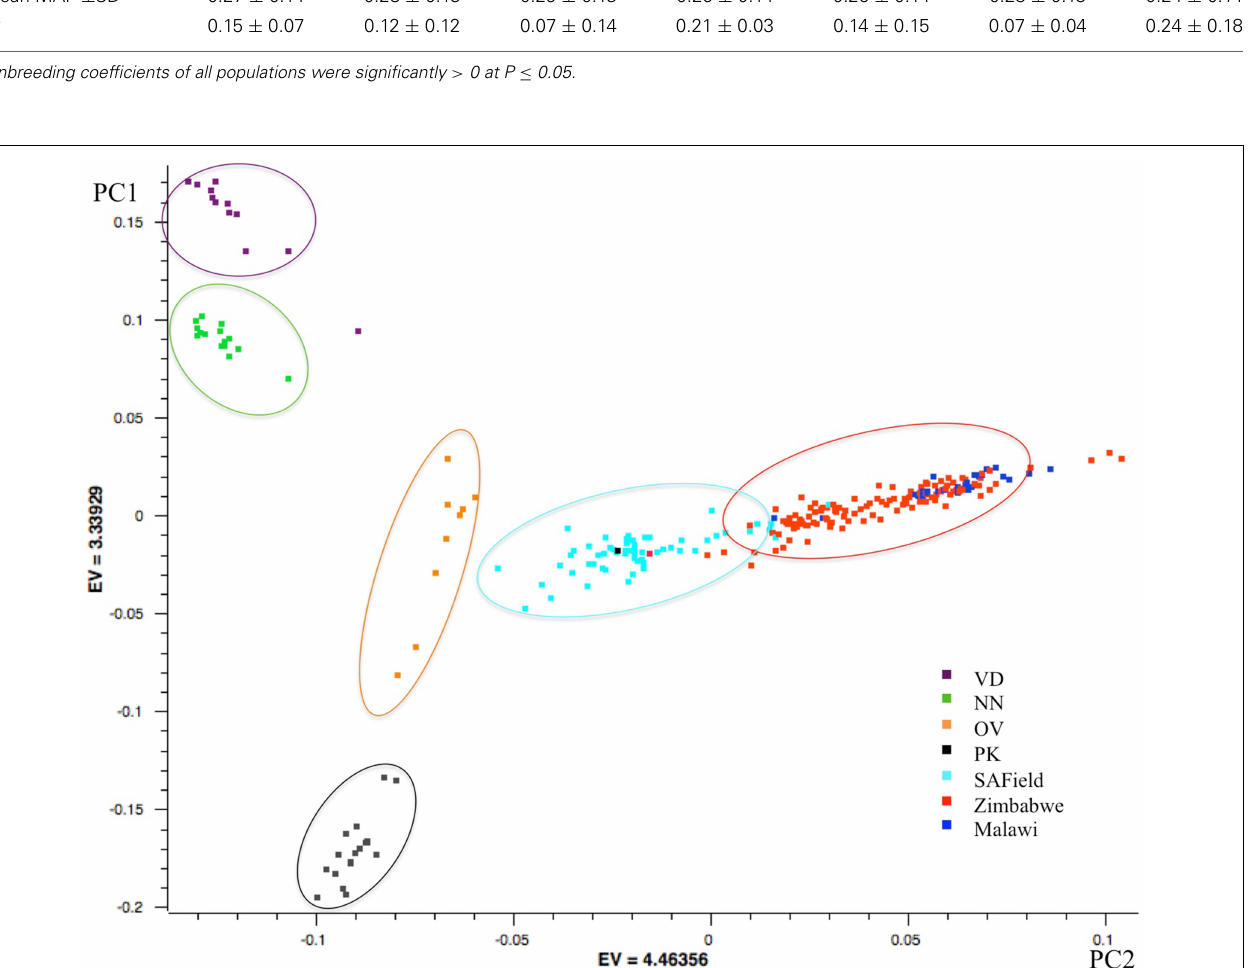
flocks; OV, Ovambo conservation flocks; PK, Potchefstroom Koekoek conservation flock; SAField, village chickens from South Africa; Zimbabwe, village chickens from Zimbabwe; Malawi, village chickens from